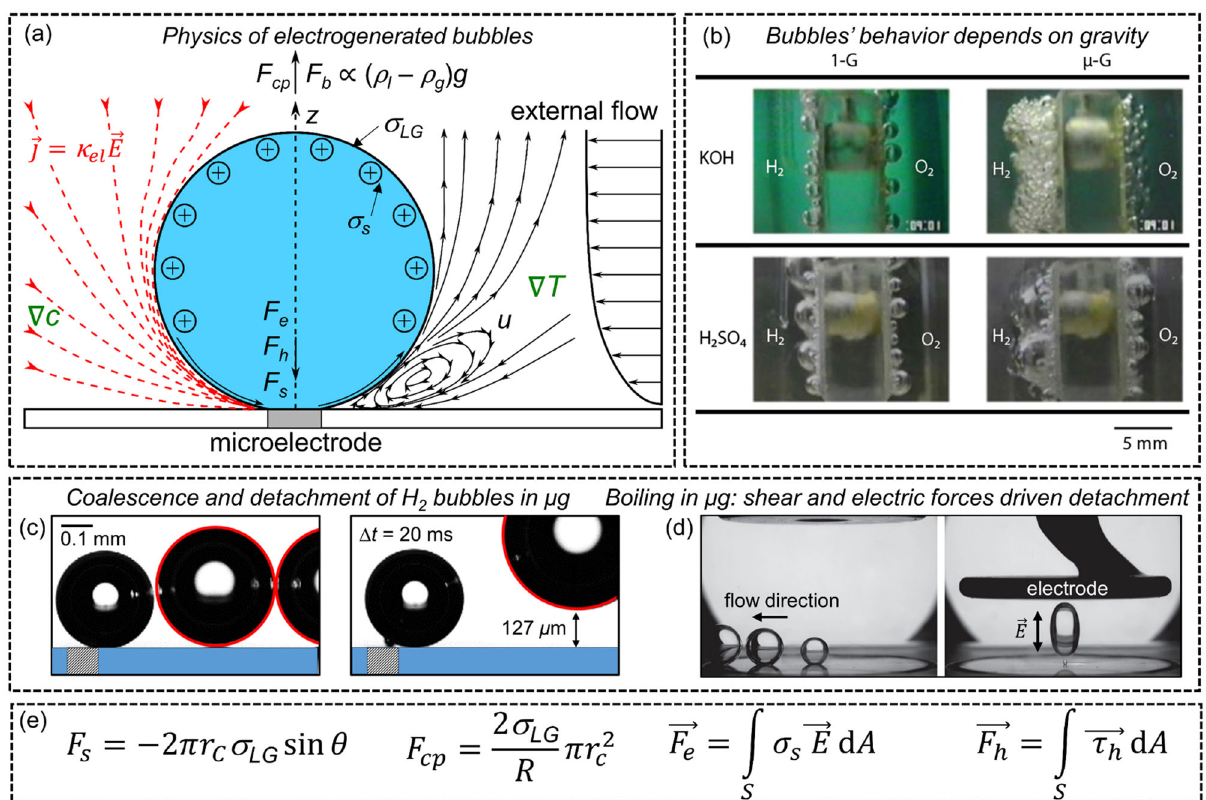
Fig. 5 Gas bubble evolution in terrestrial and reduced gravitational environments. a Scheme representing the physics of electrogenerated bubbles on microelectrodes. Red lines are the electric current lines directed from anode to cathode. The black lines show schematically the Marangoni convection at the bubble foot as observed in Yang et al. (2018) 68 . If the electrolyte ’ s pH value is below the isoelectric point, the surface charge density of the bubble, σ S , is positive as shown in ( a ), and negative otherwise 114 . b Evolution of oxygen and hydrogen gas bubbles in terrestrial (left column) and in micro-g (right column) in alkaline ( − 0.8 V vs. RHE, 25 wt.% KOH) and acidic ( − 0.8 V vs. RHE, 0.1 N H 2 SO 4 ) electrolytes. Reprinted from Electrochim. Acta, 48/28, Matsushima et al. Water electrolysis under microgravity: Part 1. Experimental technique, 4119 – 4125, 2003, with permission from Elsevier 57 . c Two hydrogen bubbles (circled in red) in microgravity shortly before their coalescence (left). The energy released by coalescence forces the resultant bubble to jump by ca. 130 µm normal to the electrode surface (right) from Bashkatov et al. (2021) 63 . d Comparison of bubble behavior during boiling with ( a ) shear fl ow and ( b ) shear fl ow with electric fi eld according to ref. 67 . e Collection of the different forces acting on the bubble in ( a